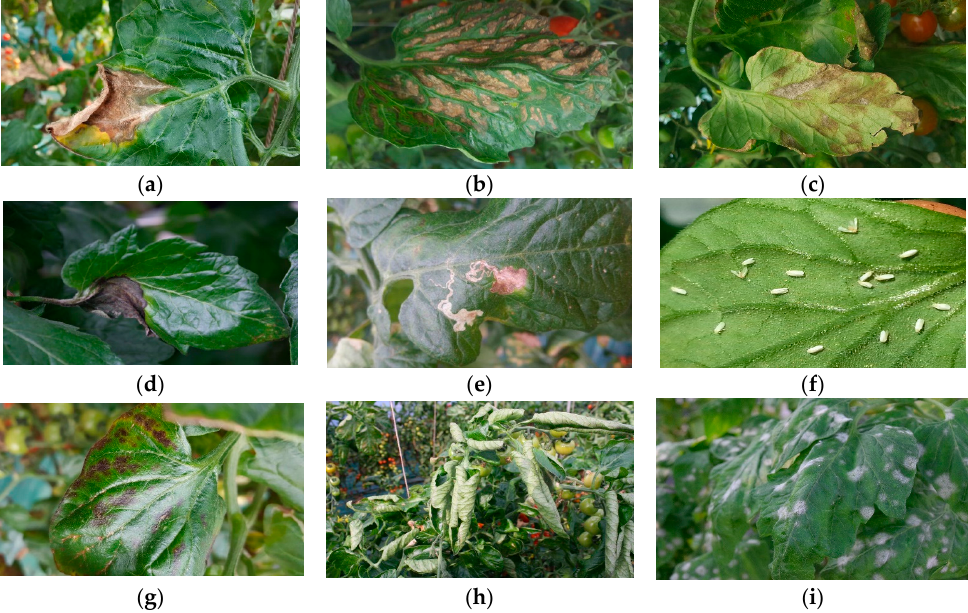
Figure 3. A representation of diseases and pests that affect tomato plants. ( a ) Gray mold, ( b ) Canker, ( c ) Leaf mold, ( d ) Plague, ( e ) Leaf miner, ( f ) Whitefly, ( g ) Low temperature, ( h ) Nutritional excess or deficiency, ( i ) Powdery mildew. The images are collected under different variations and environmental conditions. The patterns help to distinguish some proper characteristics of each disease and pest.